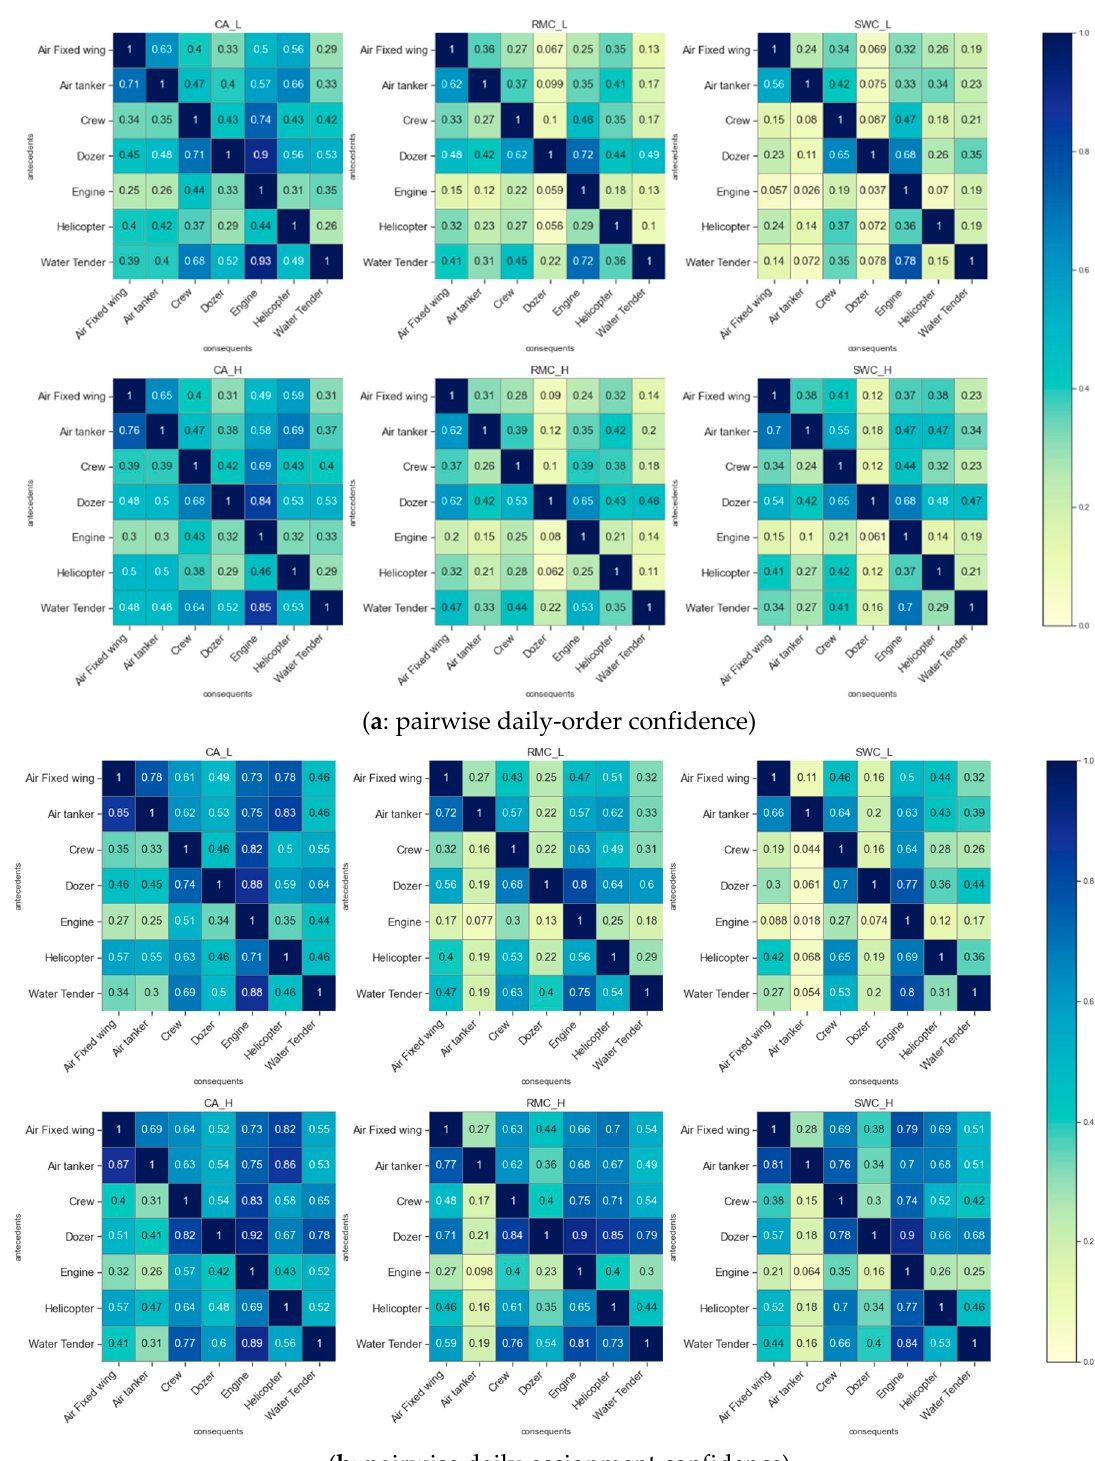
( b : pairwise daily ‐ assignment confidence) Figure 5. Confidence heatmaps for: ( a ) daily resource ordering and ( b ) daily resource assignments for three GACCs at both high and low PL, i.e., CA_H represents GACC California (CA) at high PL, CA_L denotes the same GACC at low PL.